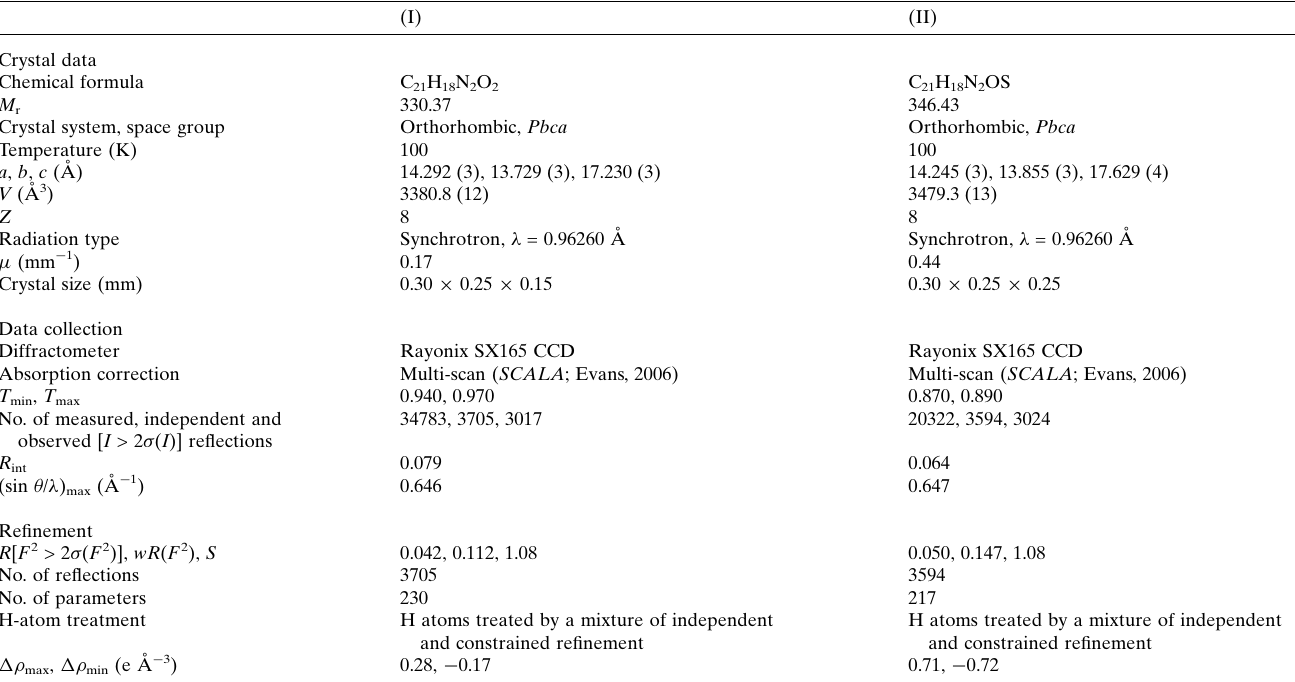
Table 3 Experimental details.